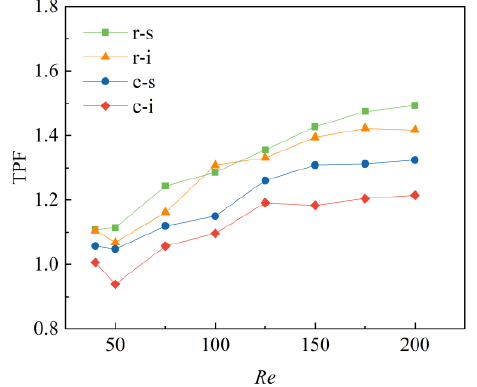
Figure 12. Thermal-hydraulic performance factor in four types of micro-pin-fin array.